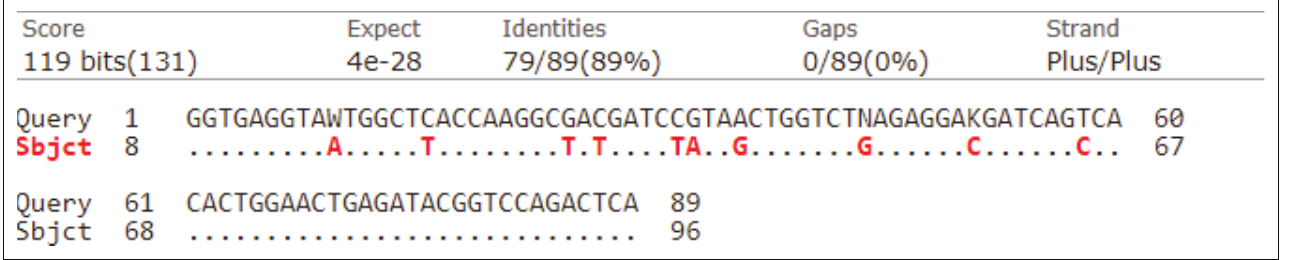
Source : Figure constructed by authors using NCBI-BLASTn online program (https://blast.ncbi.nlm.nih.gov/Blast.cgi). Sbjct, subject. FIGURE 3-A1: BLASTn result showing the alignment of E. canis isolate (Vietnam-MH686052.1) and one sequence ( E. canis KZN-Hlabisa isolate) obtained from the study. Nucleotide identity is represented by